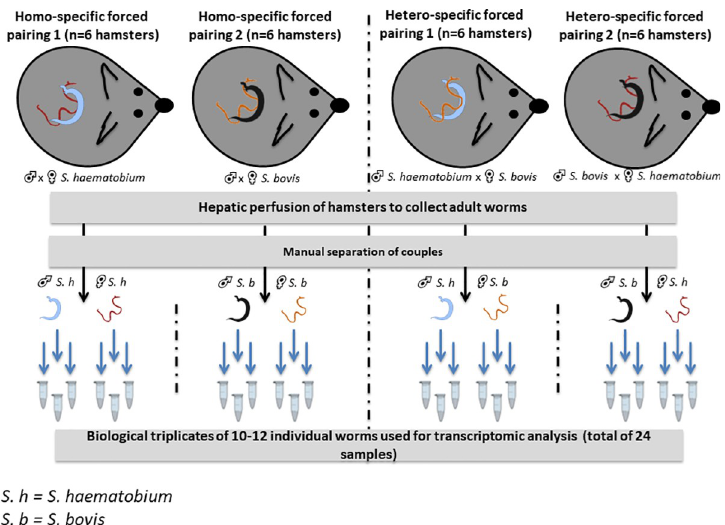
Fig 2. Schematic representation of the procedure used to obtain the reciprocal homo- and hetero-specific pairs of S . haematobium and S . bovis